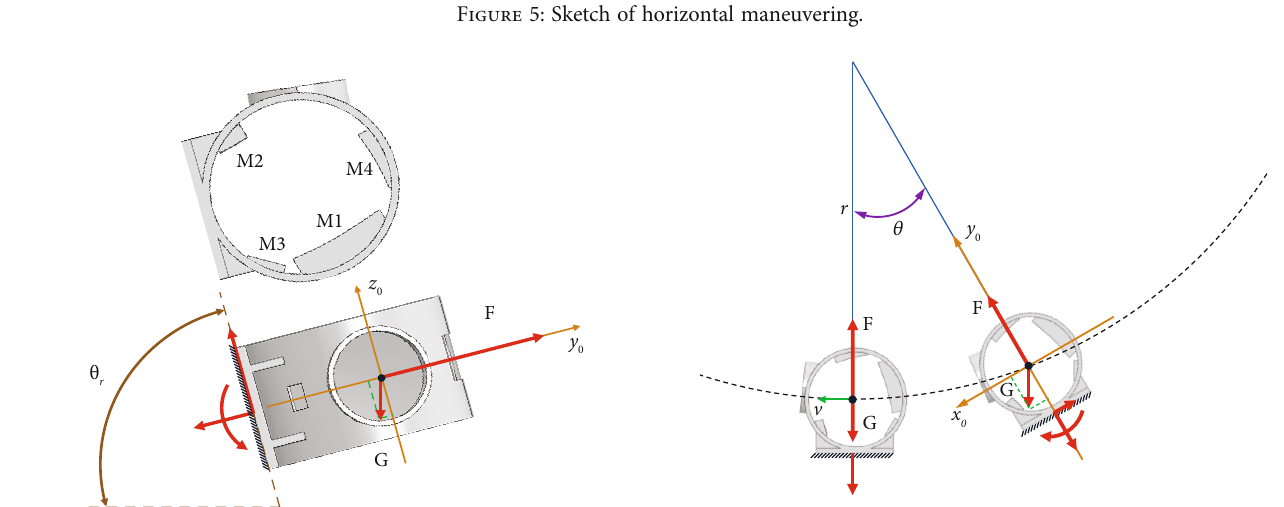
Figure 8: Force analysis diagram of the multiplanar conformal o ff - axis